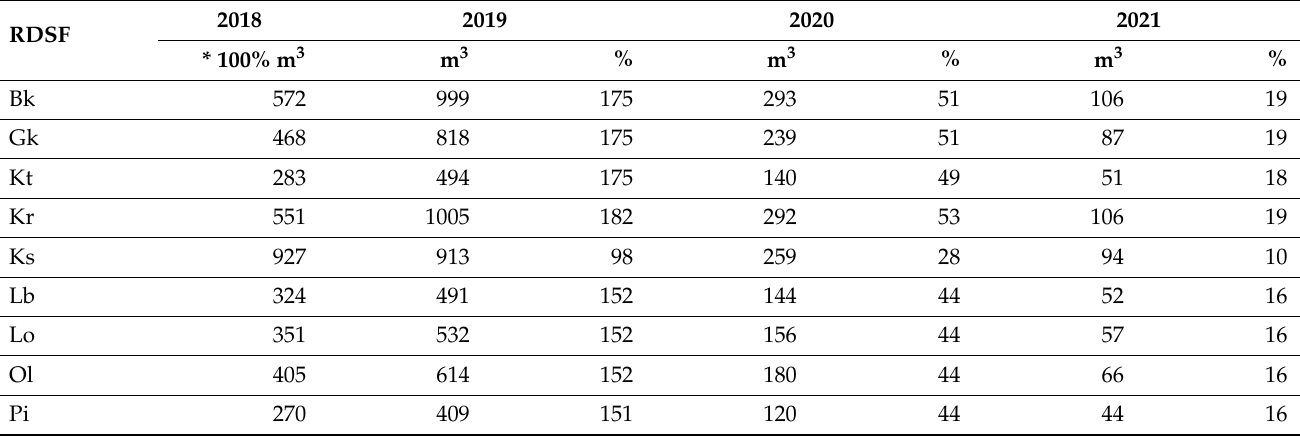
Table 8. Stump wood biomass structure from